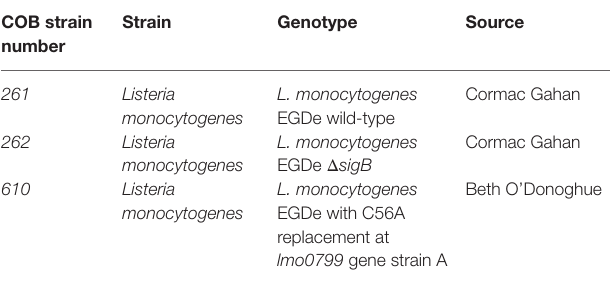
TABLE 1 | Bacterial strains used in this